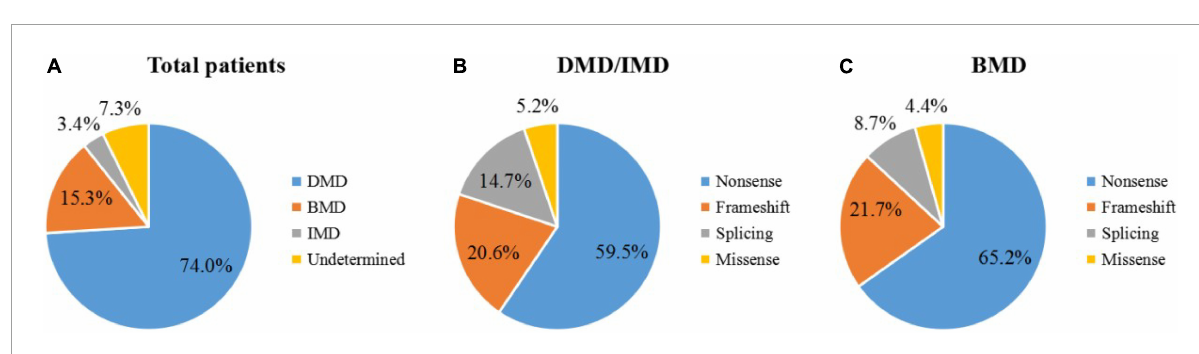
FIGURE2 Distribution of small mutations. The ratios of mutation types in all patients (A) , DMD/IMD (B) , and BMD (C) .